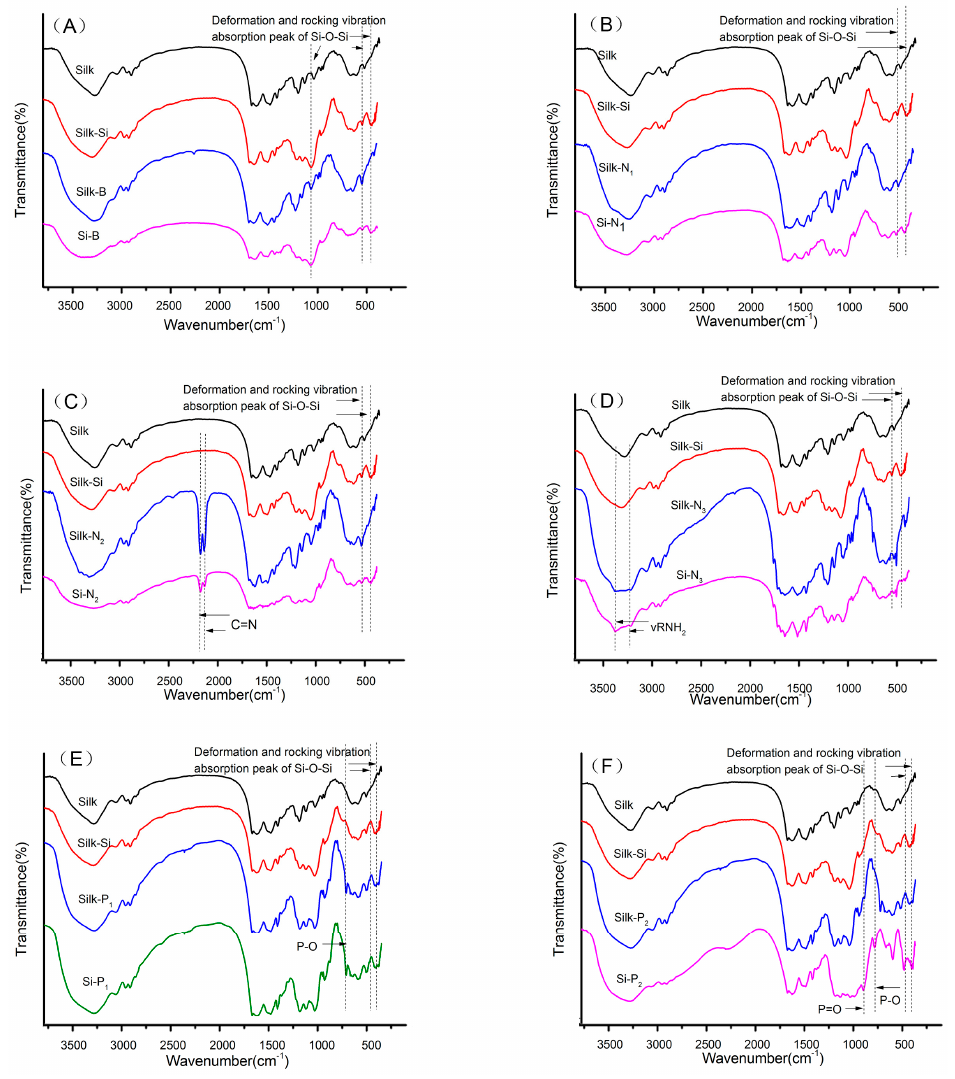
Figure 10. FTIR spectra of all samples. Silk, Silk-Si, Silk-B, Si-B ( A ); Silk, Silk-Si, Silk-N1, Si-N1 ( B ); Silk, Silk-Si, Silk-N2, Si-N2 ( C ); Silk, Silk-Si, Silk-N3, Si-N3 ( D ); Silk, Silk-Si, Silk-P1, Si-P1 ( E ); Silk, Silk-Si, Silk-P2, Si-P2 ( F ).